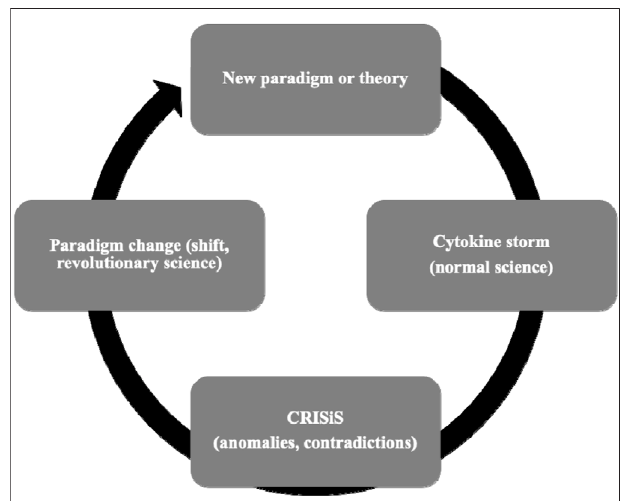
FIGURE 1 | Adapted Kuhn cycle of scienti fi c advancement using the cytokine storm paradigm as